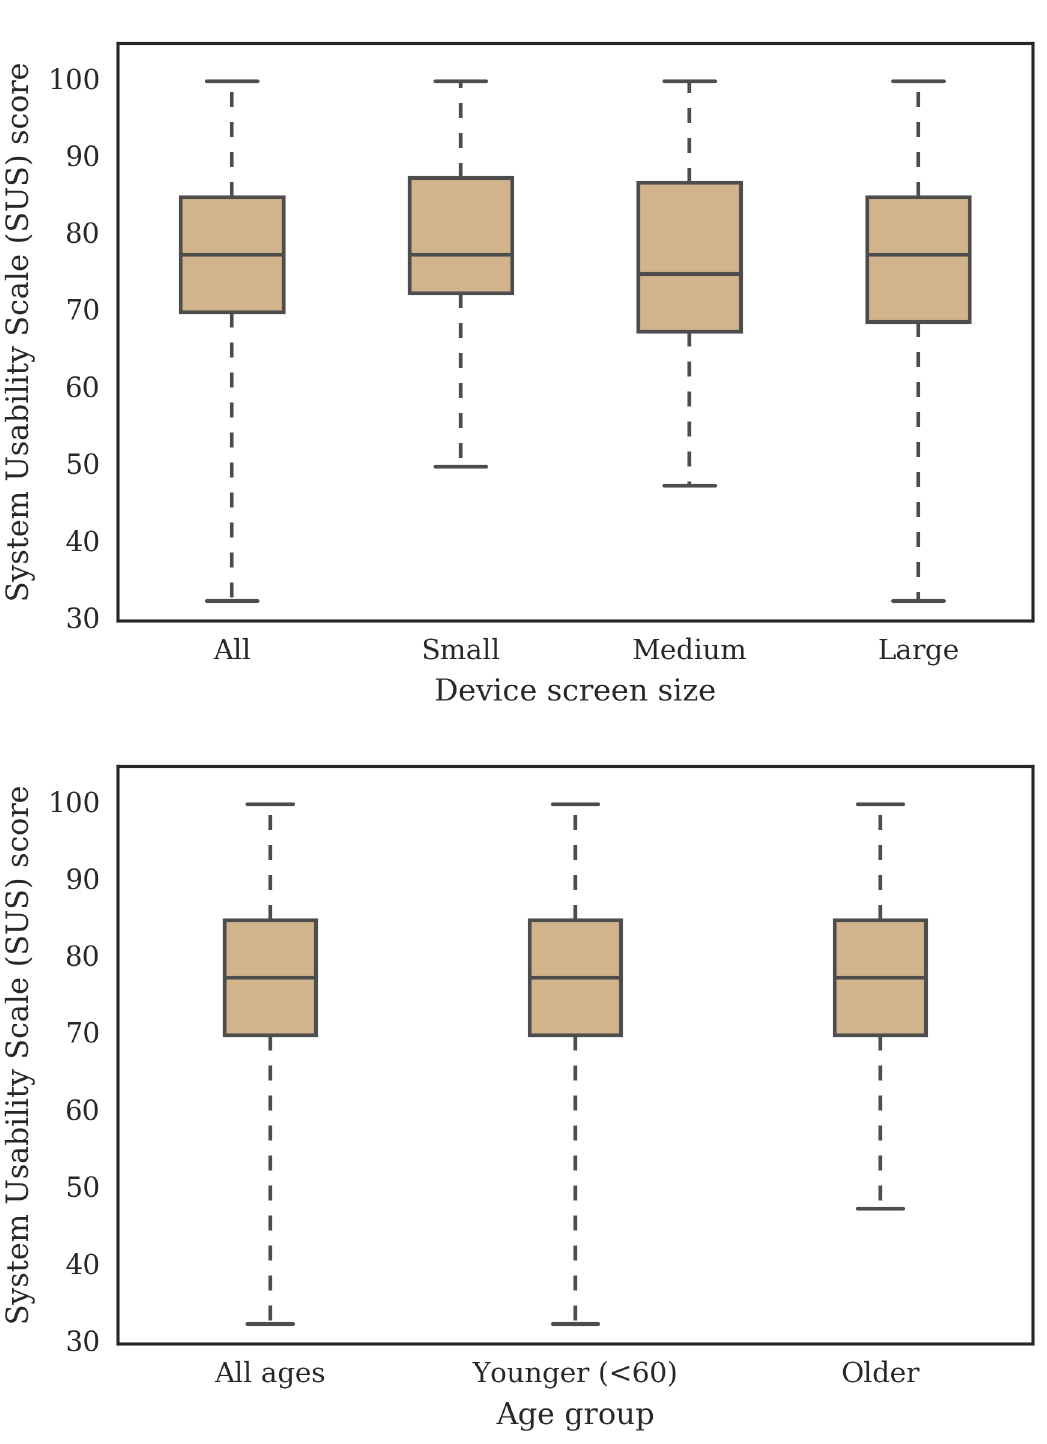
Fig 2. System Usability Scale (SUS) score for participants (n = 322) who completed the EatWellUK study presented by small (n = 92), medium (n = 38) and large (n = 191) device screen sizes and by younger (n = 268 < 60 years) and older (n = 53) adults. The device screen sizes were classified as small (less than 480 pixels), medium (between 480 and 1240 pixels, inclusive) and large (more than 1240 pixels).